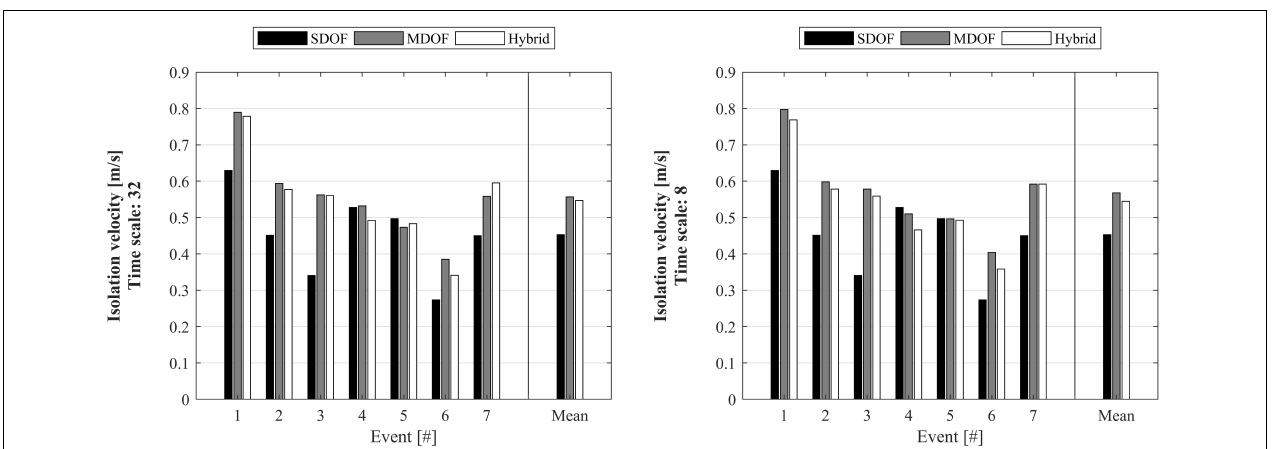
FIGURE 10 | Isolation velocity response—time scales 32 and 8.